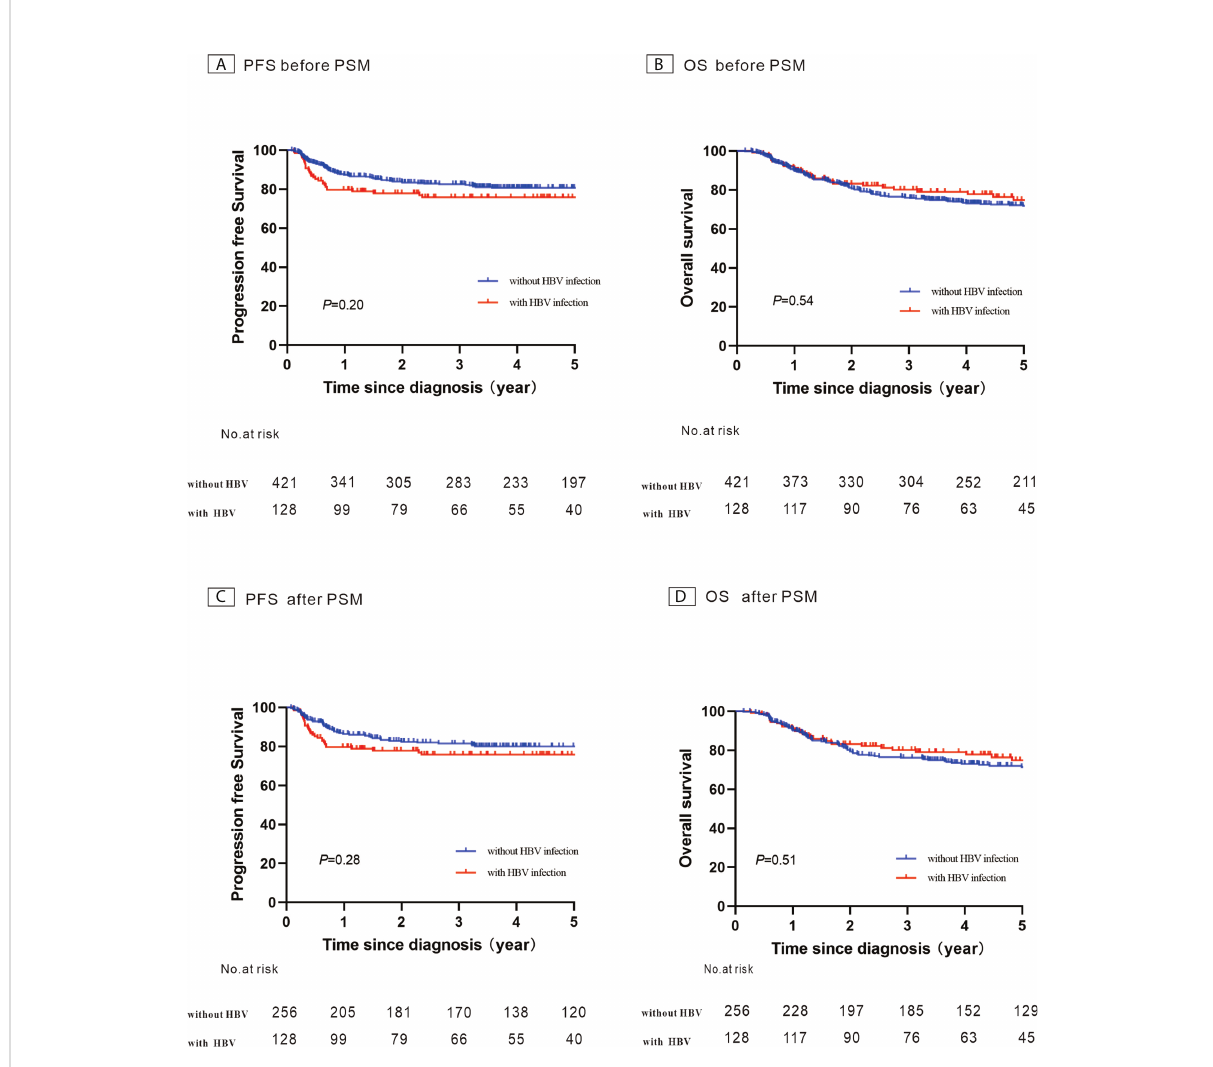
FIGURE 4 Kaplan – Meier survival curves for patients with diffuse large B-cell lymphoma constructed using their hepatitis B virus (HBV) infection status. (A) Progression-free survival (PFS) before propensity score-matched (PSM) analysis; (B) Overall survival (OS) before PSM analysis; (C) PFS after PSM analysis; (D) OS after PSM